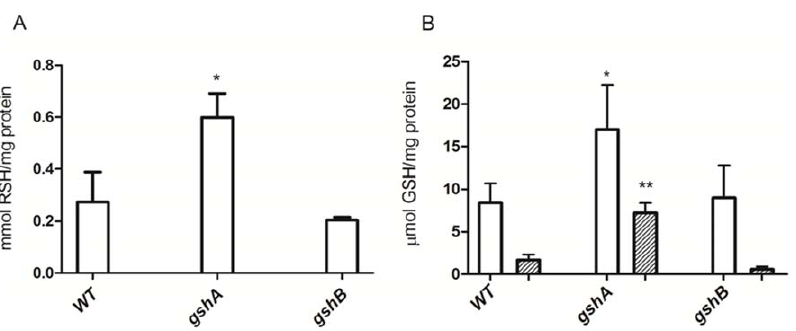
Figure 1. Total RSH and GSH content in E.coli overexpressing GSH biosynthesis genes. Cellular RSH (after 4 h IPTG induction, A) and GSH levels (B) after 4 h (white) or 16 h (striped) IPTG induction were determined in E. coli AG1 (wt), AG1/pCA24N gshA ( gshA ) and AG1/pCA24NgshB ( gshB ) cells (n=3). *p , 0.05; **p , 0.005.